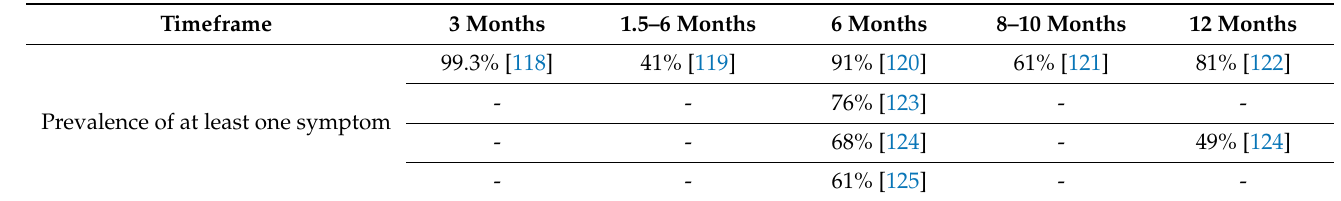
Table 5. The persistence of at least one symptom during long COVID at different timeframes.